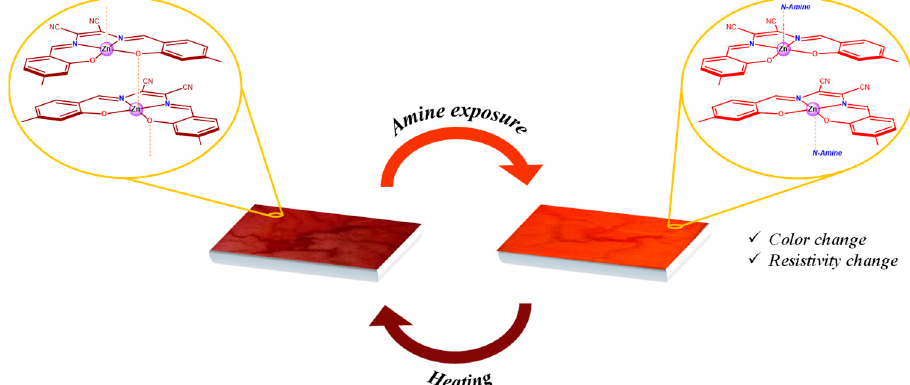
Figure 14. Sketch of vapochromic and chemiresistive characteristics of the Zn(salmal) complex having 4,4 ′ -alkoxy substituents in the salicylidene rings upon chemisorption/desorption of a volatile aliphatic amine.